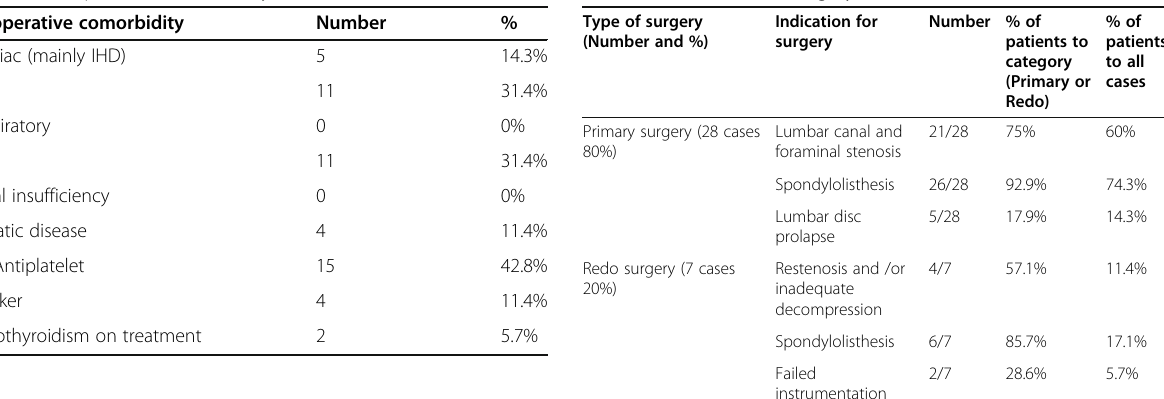
Table 5 Indication for surgery